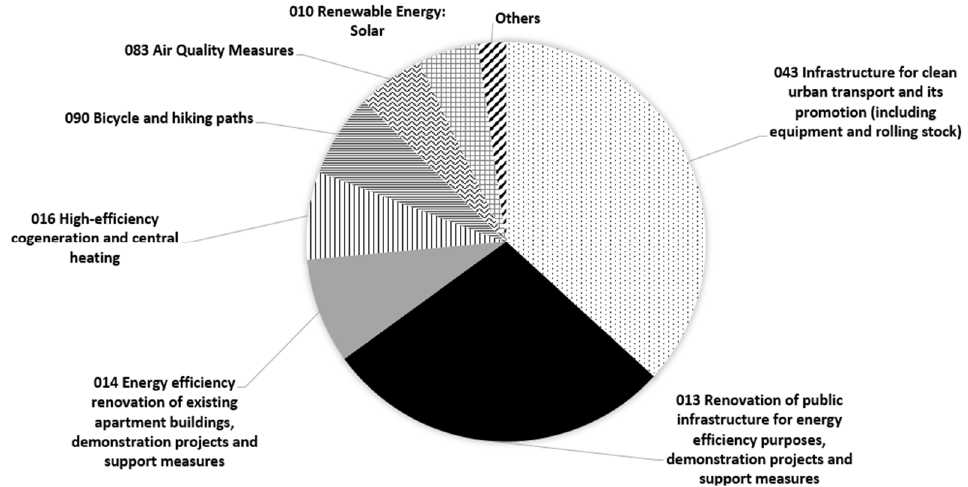
Figure 2. Support area for 2014–2020 projects implemented by the metropolises in the field of low- carbon economy in Poland. Source: Own compilation based on data from the Polish Ministry of Development and Economic Investment [79]. Table 2. Investment activity of metropolises in obtaining EU funds for the low-carbon economy in Poland in the 2014–2020 Financial Perspective.